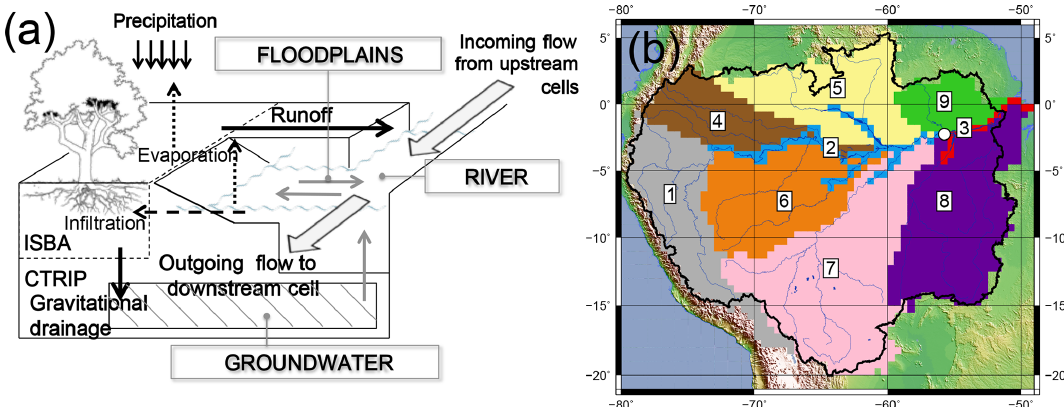
Figure 1. (a) The ISBA-CTRIP system for a given grid cell. ISBA surface runoff ( Q ISBA,sur ) flows into the river/surface reservoir S , and ISBA gravitational drainage ( Q ISBA,sub ) feeds groundwater reservoir G . The surface water is transferred from one cell to another following the TRIP river routing network. (b) Hydro-geomorphological areas of the Amazon basin from Emery et al. (2016) with the gauge of Óbidos located by the white circle at the entry of zone